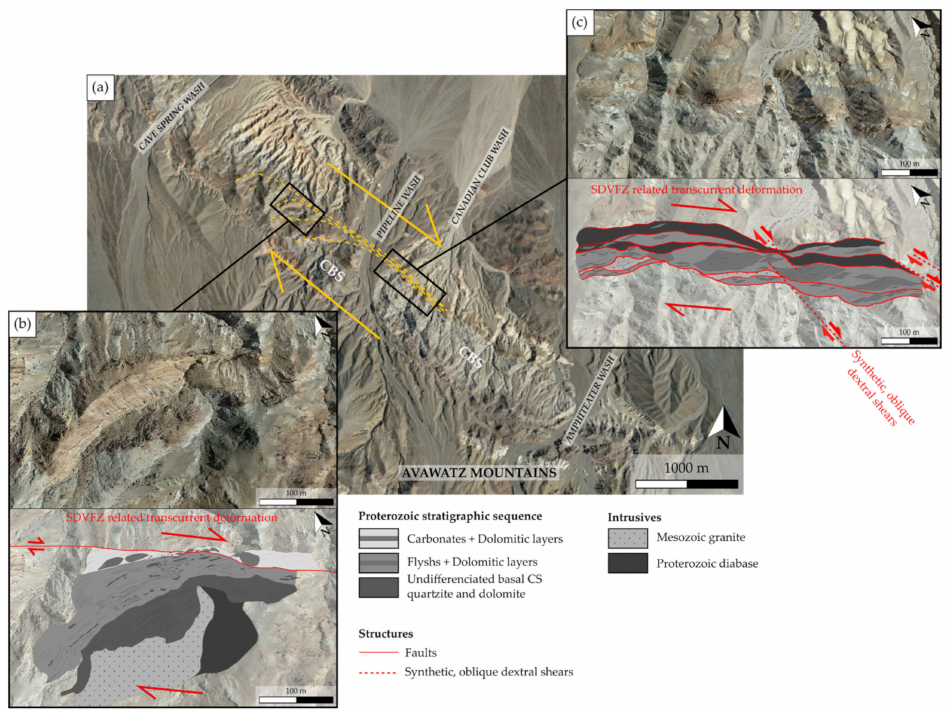
Figure 2. ( a ) Satellite view of the NH range showing a deformation gradient increasing southeastward, represented by the yellow dashed lines. ( b , c ) Map view zooms on the Proterozoic units along the NH strike showing the strain increase from ( b ) to ( c ), where basal CS sedimentary sequence appears increasingly stretched and